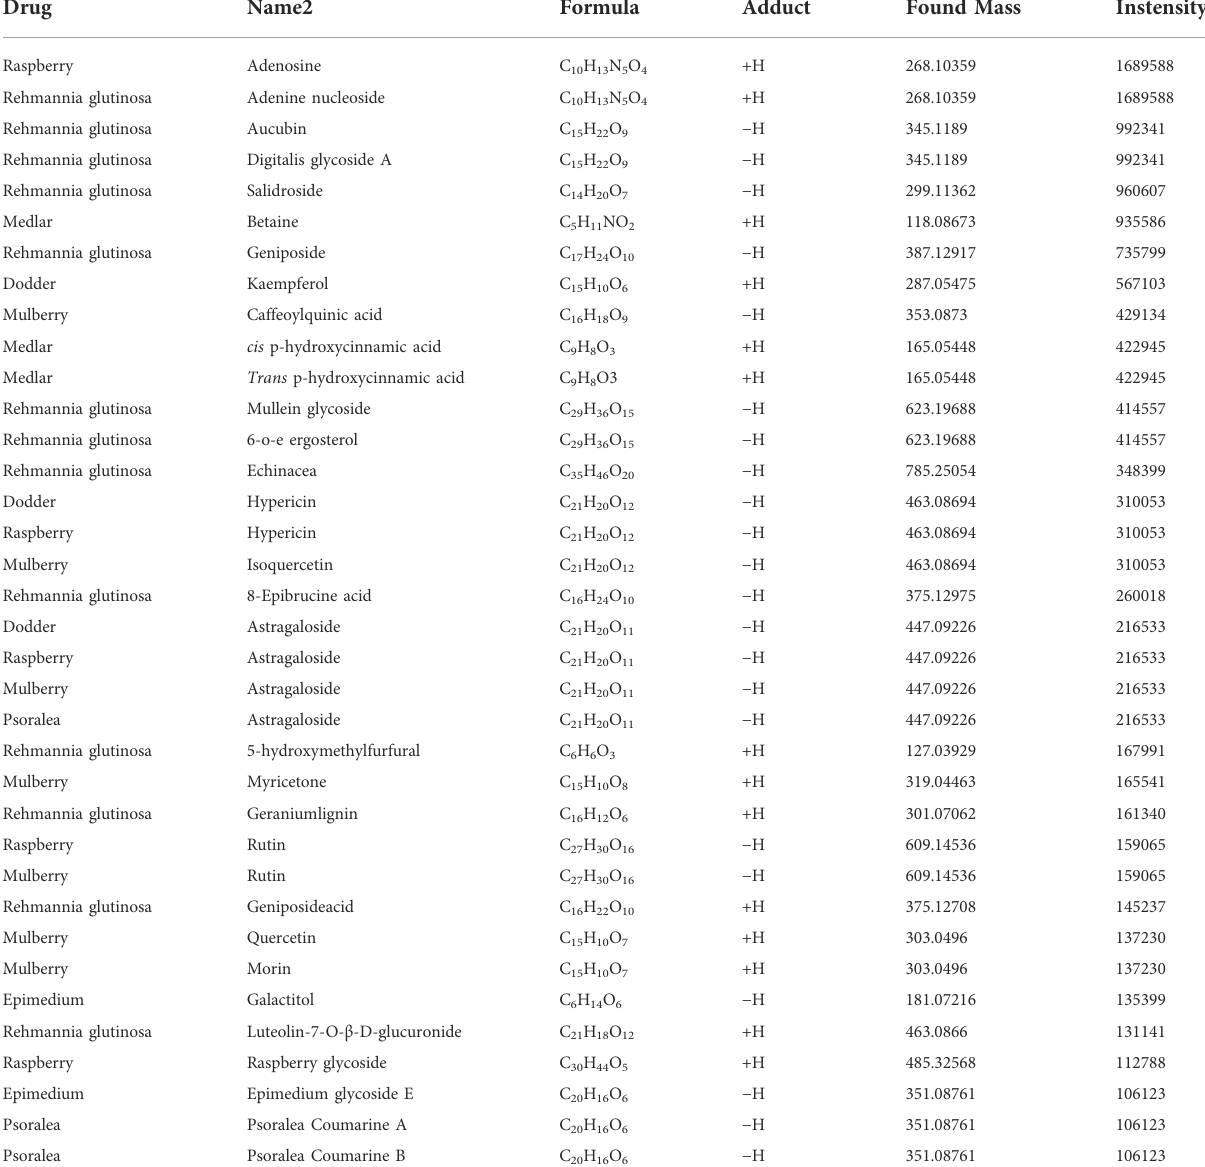
TABLE 1 Detection results of active components of herb by mass